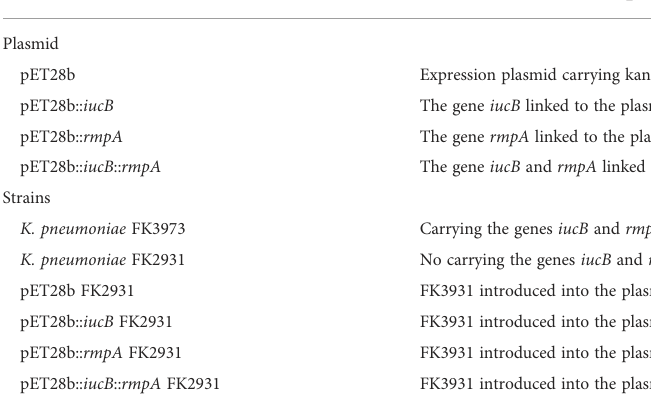
TABLE 1 Plasmids and bacterial strains used in this study. Plasmid or strains